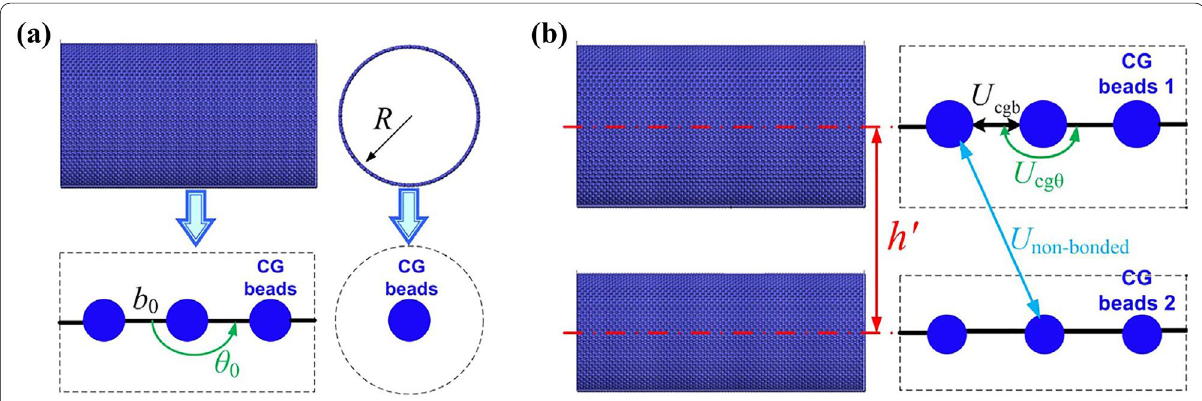
Figure 10 Two parallel CNTs and their CG model. The full-atom atomic structure and CG model for ( a ) a CNT and ( b ) two parallel